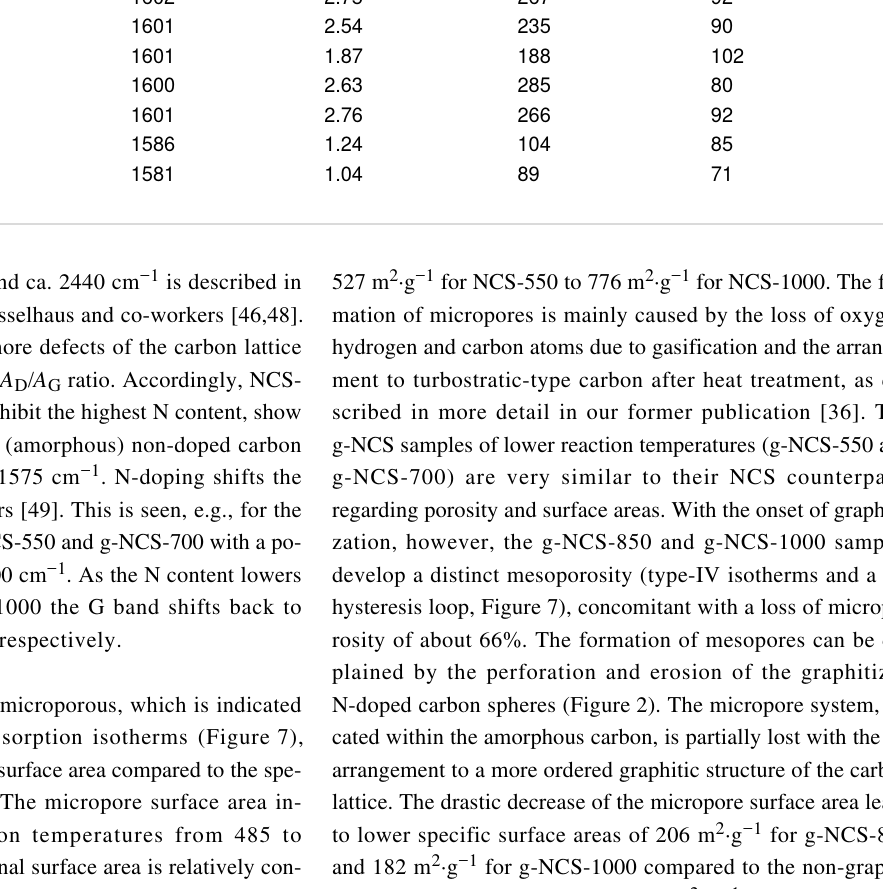
Table 3: Position and ratio of the band areas A D / A G and full width at half maximum of the carbon D- and G-bands in the Raman spectra. sample